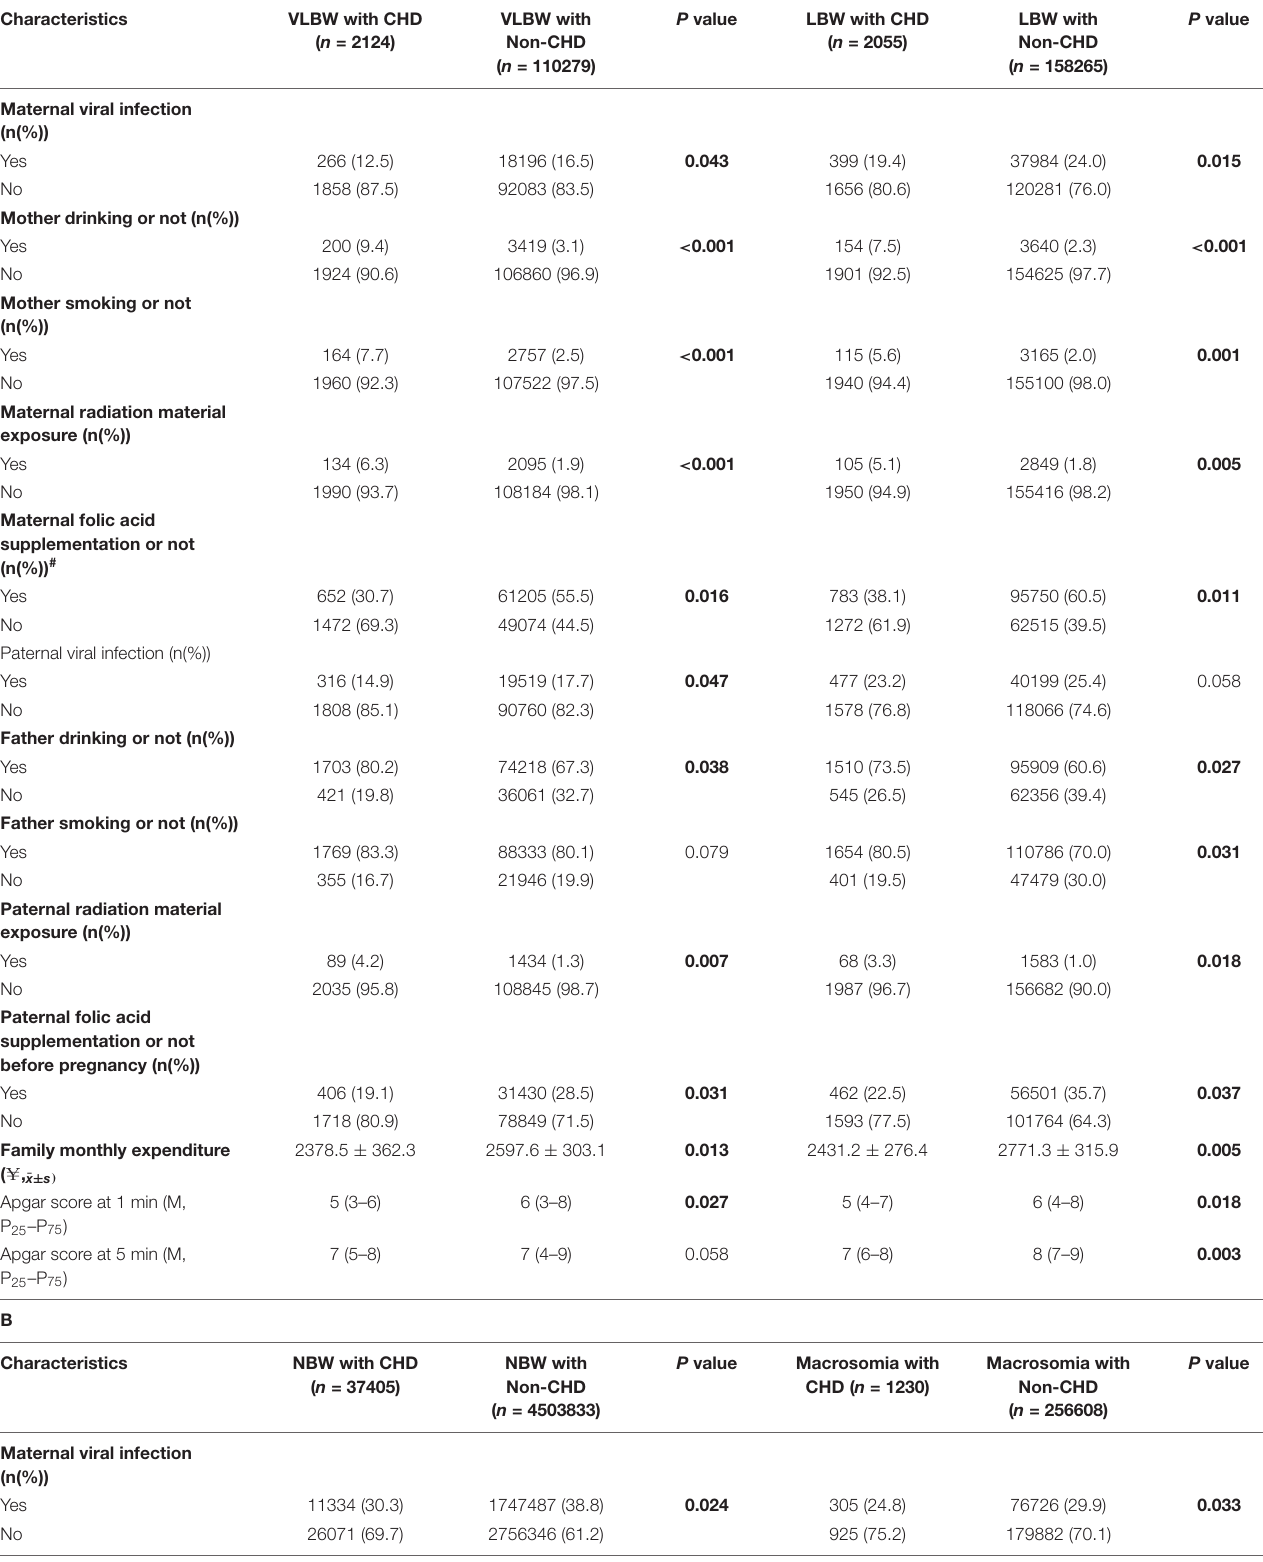
TABLE 3 | Characteristics of children of the same birth weight between CHD and non-CHD